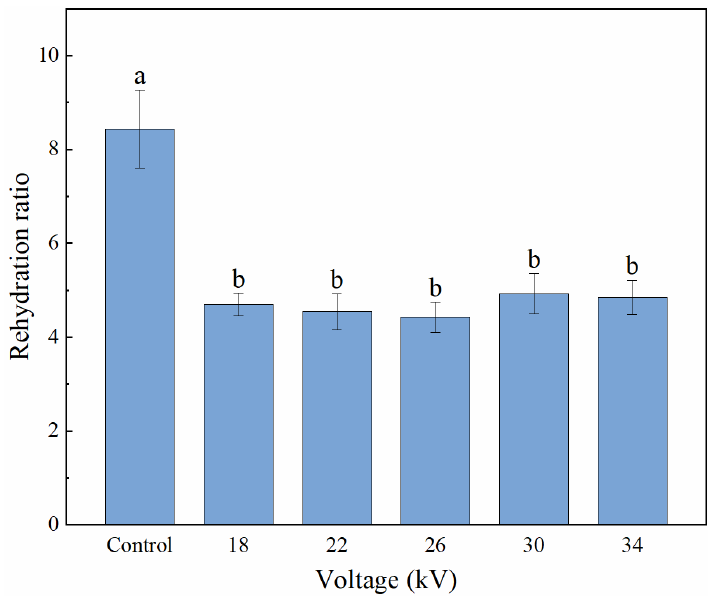
Figure 7. Rehydration ratio of shiitake mushroom slices. Different letters indicate significant differ- ences ( p < 0.05) between sample means.